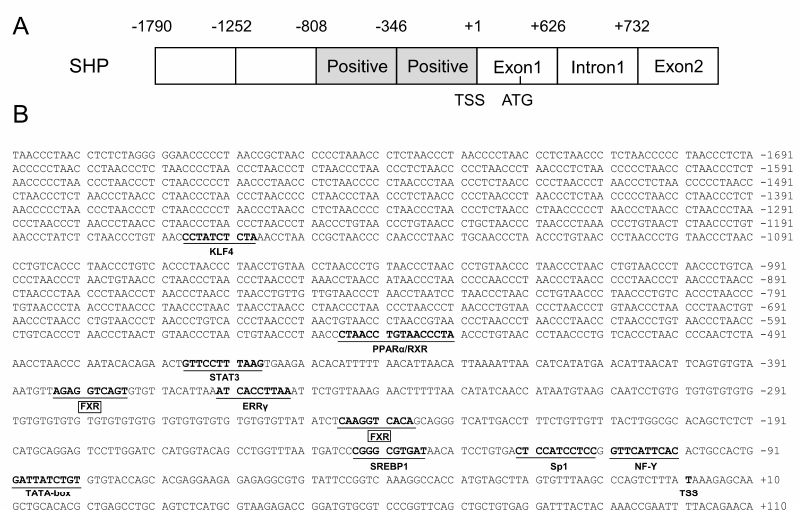
Figure 1. ( A ) The schematic diagram of SHP gene structure. The first nucleotide of 5 (cid:48) cDNA of SHP was designated as +1. Positive: the region that positively regulated the promoter activity. TSS: